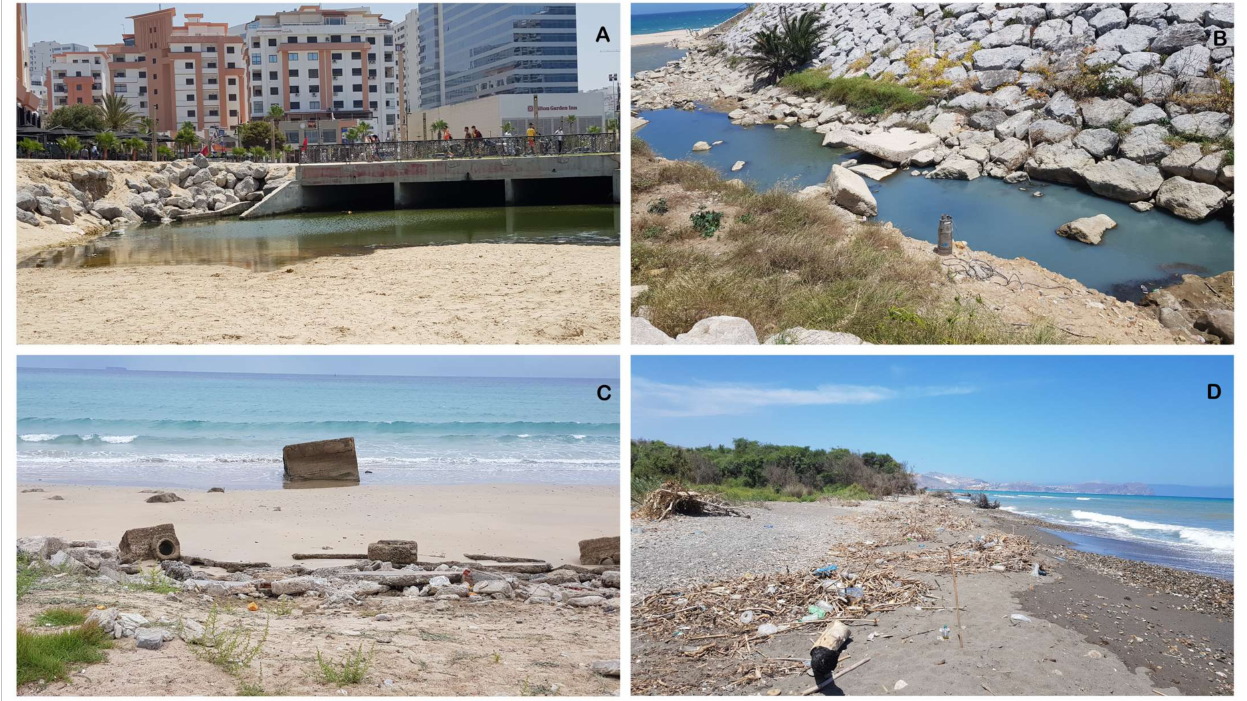
Figure 8. Examples of Class V sites showing some landscape features of urban areas such as buildings and the presence of public facilities (( A ), M’Diq; ( B ), Ghandouri; ( C ), Tangier Municipal).